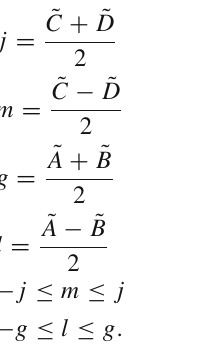
Fig. 2 A correlation of two base-2 sequences, which is a base-4 sequence and an element of S 2 ( n ) , can be visualized as a directed edge connecting two vertices. By choosing a reference sequence, we can assign quantum numbers to the remaining base-2 sequences and order the points introduced in Fig. 1 accordingly. For the case shown here, the quantum numbers are j 01 = 3 , m 01 = + 1 , g 01 = 3 , and l 01 = + 1 2 2 2